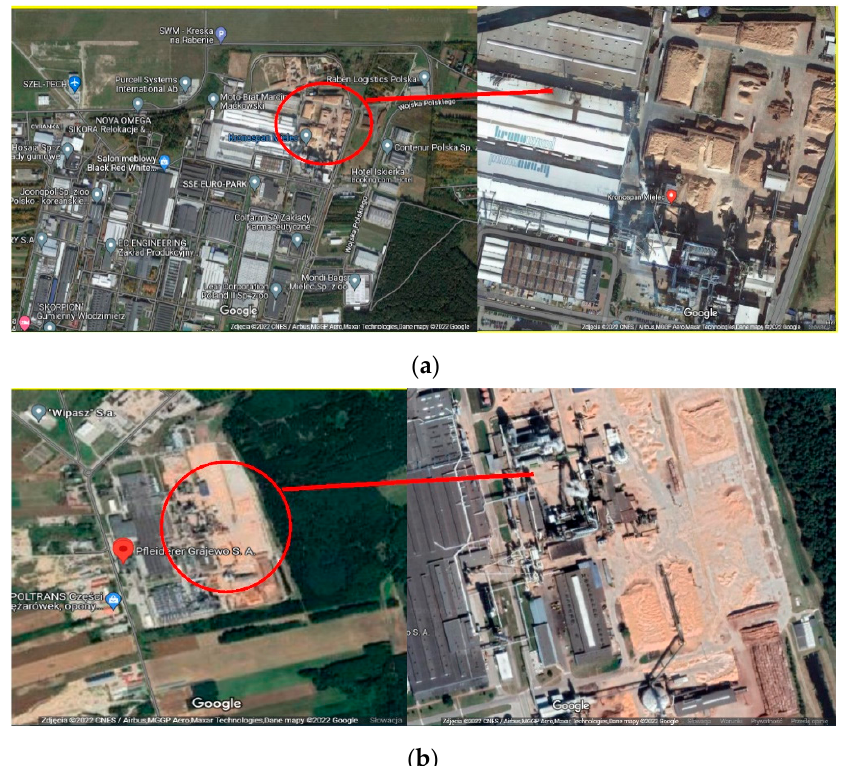
Figure 1. ( a ) Satellite image of the Kronospan Sp. z o.o. group factory in Mielec. ( b ) Satellite image of the Pfleiderer Polska sp. z o.o. factory in Grajewo (www.google.com/maps, accessed on 31 July 2022).